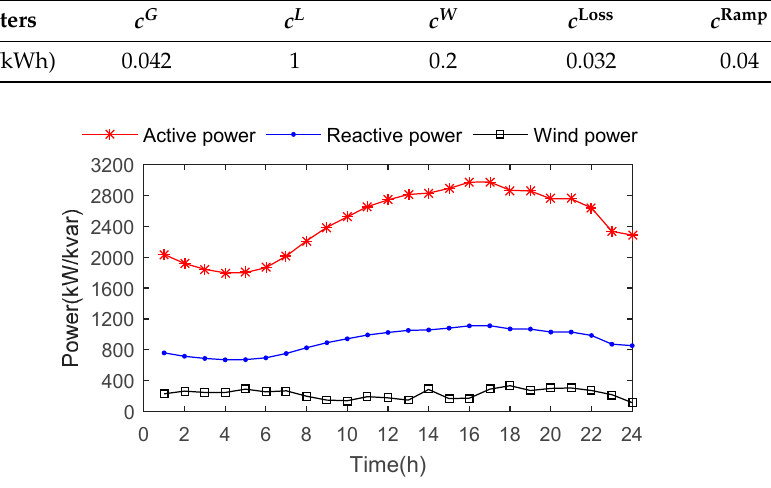
Figure 5. Wind power output and load curves.